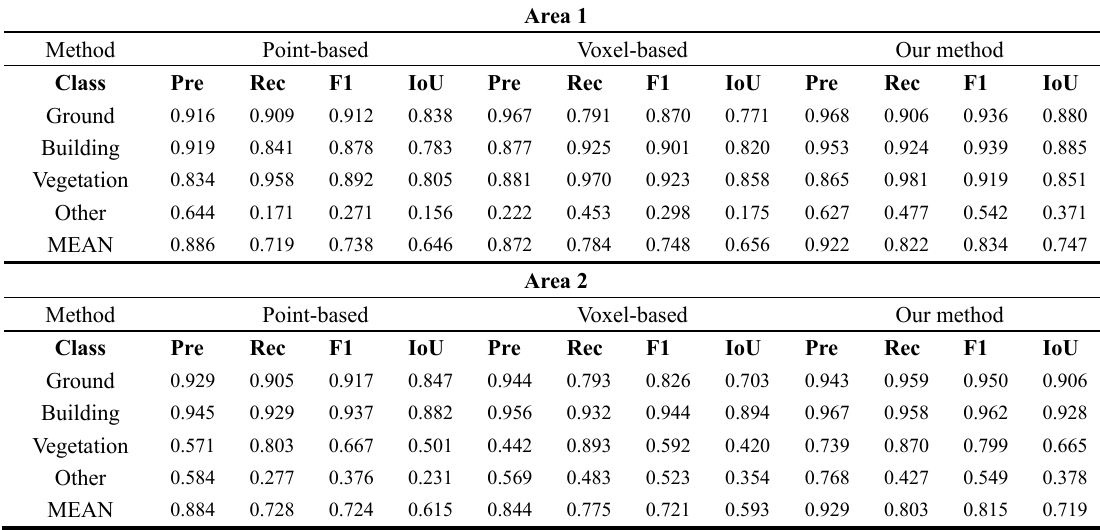
Table 2. Quantitative analysis of classification results .